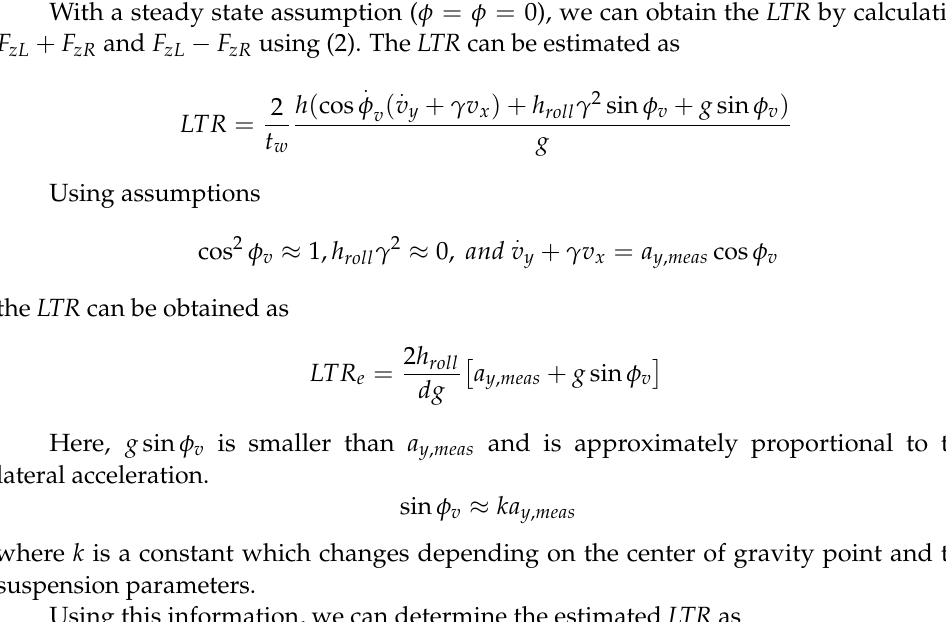
Figure 2. Roll model of vehicle dynamics.